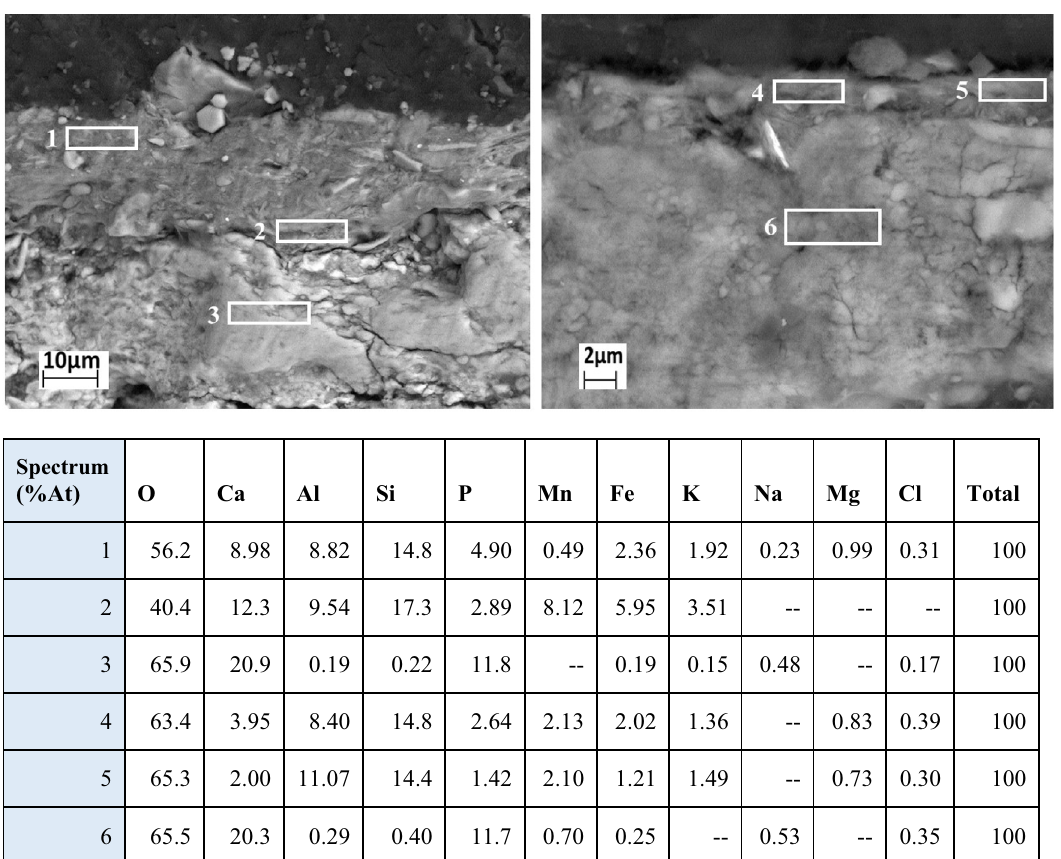
Fig. 4 Non-irradiated bone cross-sections observed on micro- graphs obtained by FE-SEM under different magnification. EDS analyses performed on the indicated areas are summarized in the table below. The presence and distribution of Ca and P, essential components of bone, is confirmed and observed to increase